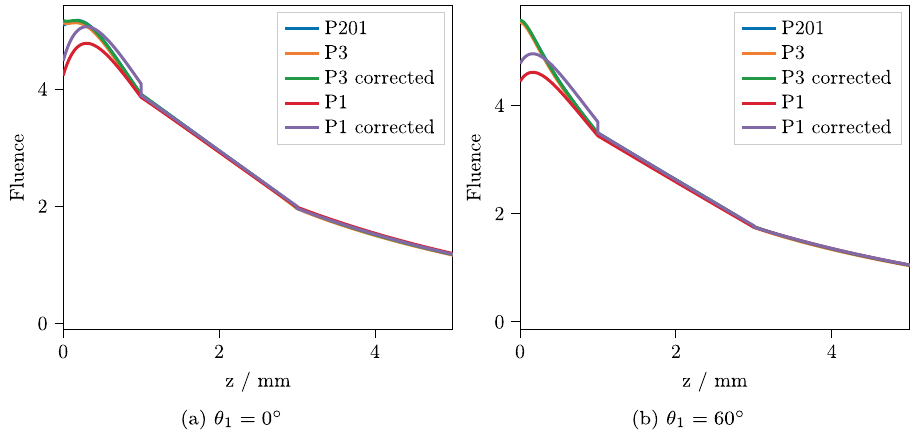
Figure 2. Depth-resolved fluence rate for the three-layered system, integrated over x and y . The P 201 solution can be regarded as practically exact. For the corrected solutions, the total absorbance per layer was matched to the P 201 solution.